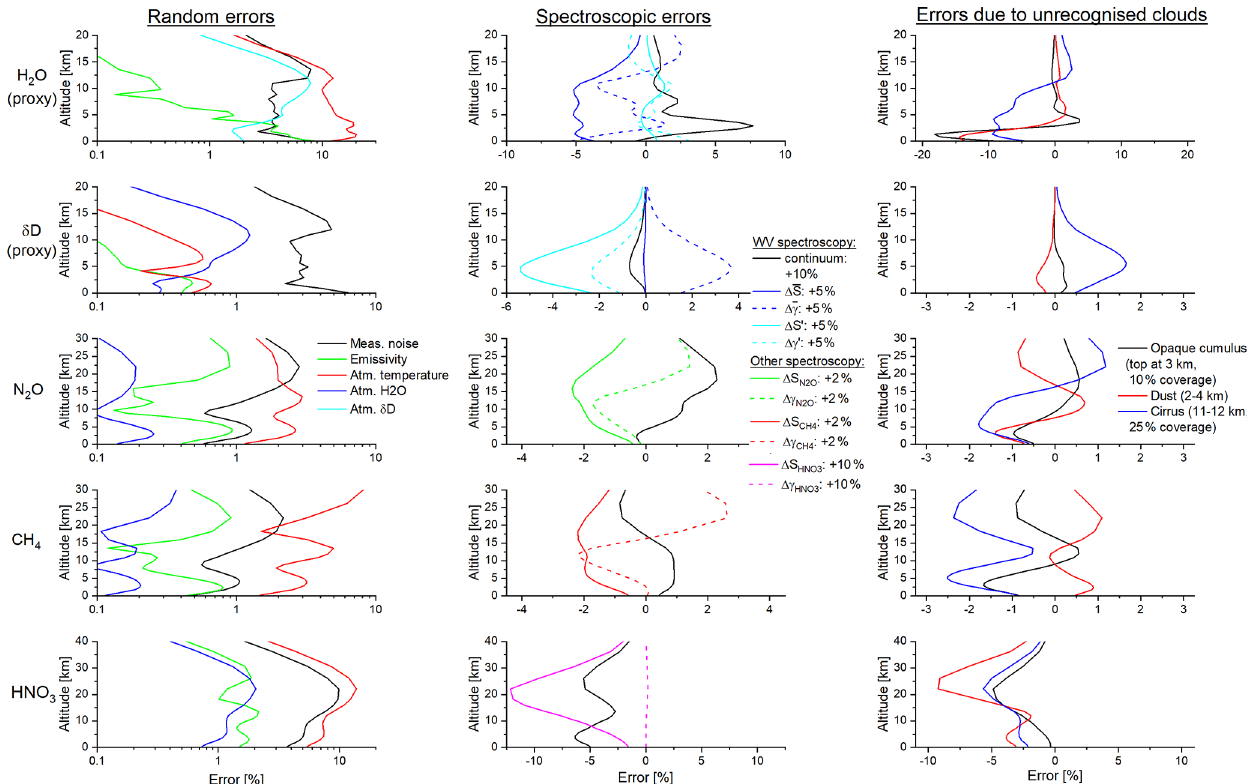
Figure 12. Example of error profiles estimated for all targeted atmospheric species: H 2 O, δ D, N 2 O, CH 4 , and HNO 3 . Please note that for the species H 2 O and δ D the estimation is made for the respective proxies 1 calculated according to the uncertainty assumptions of Table 3 and for the 30 August 2008 example observation over Lindenberg used for Figs. 4 and